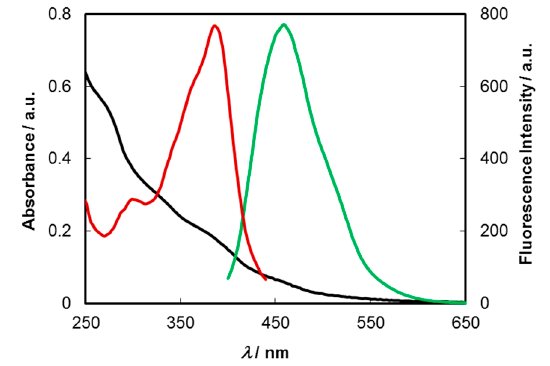
Figure 2. UV–Vis (black line), excitation (red line; monitored at 460 nm) and emission (green line; λ exc = 380 nm) spectra of an aqueous solution of C-dots (0.1 mg/mL).